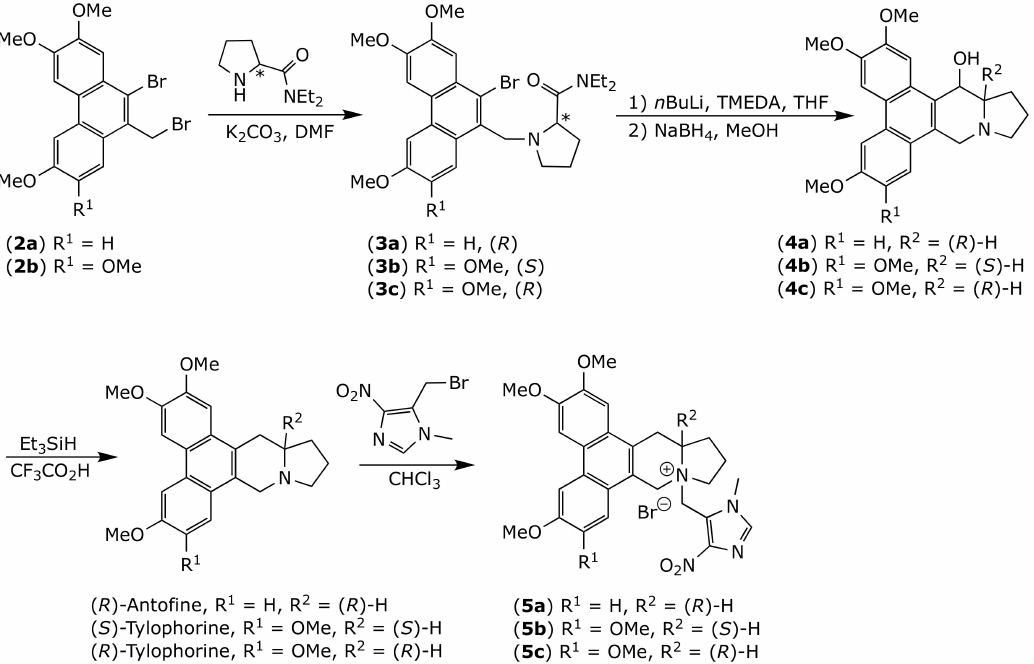
Figure 3. Chemical synthesis of prodrugs 5a – c